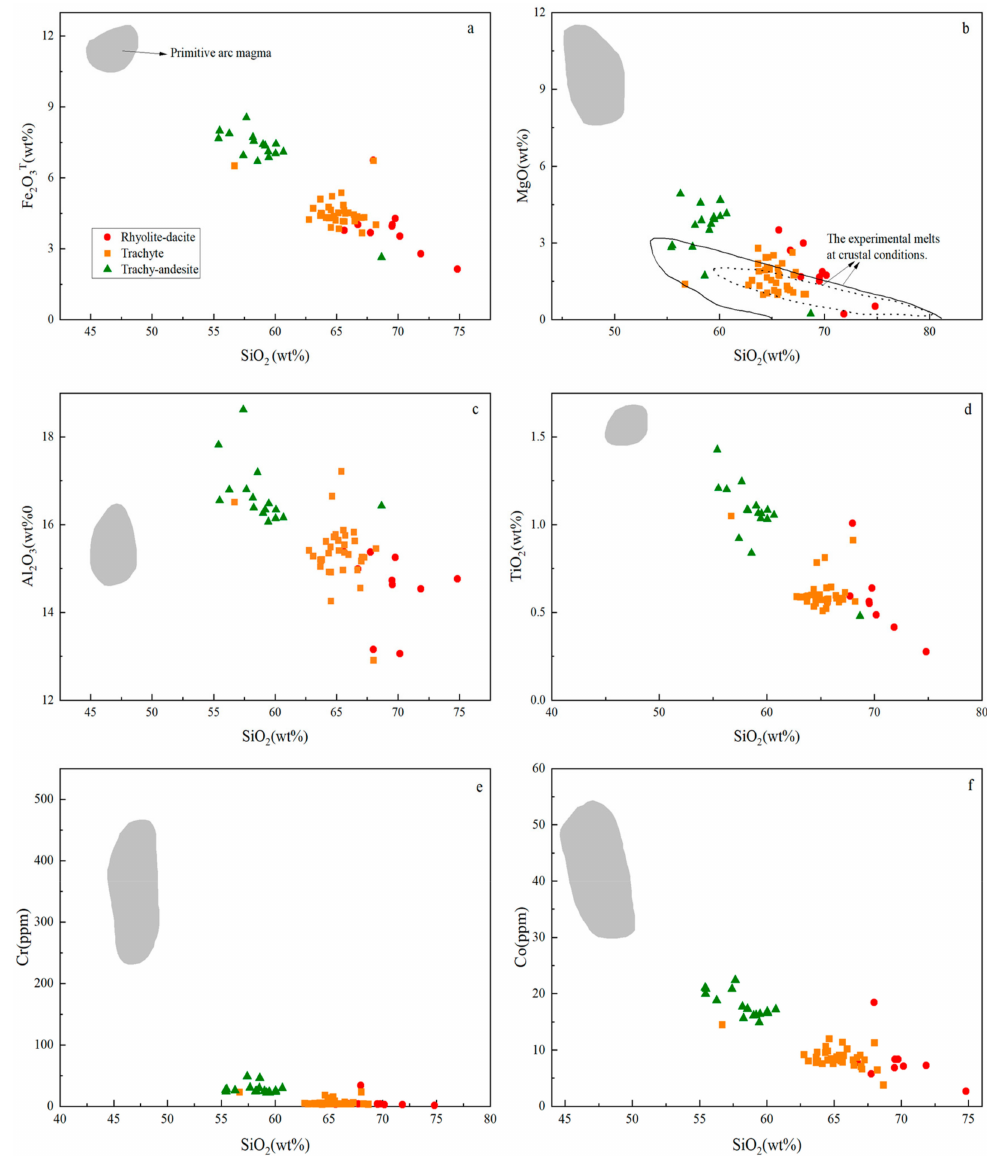
Figure 7. Diagrams of various major oxides and trace elements versus SiO 2 for volcanic rocks from the Shanghang Basin. ( a ) Fe 2 O 3T ; ( b ) MgO; ( c ) Al 2 O 3 ; ( d ) TiO 2 ; ( e ) Cr; ( f ) Co. The gray shaded area represents primitive arc melt [52]. The dotted line represents the field of experimental crust melts, data from [36]. the solid line represents the field of metabasaltic and eclogite experimental melts at 1–4 GPa, data from